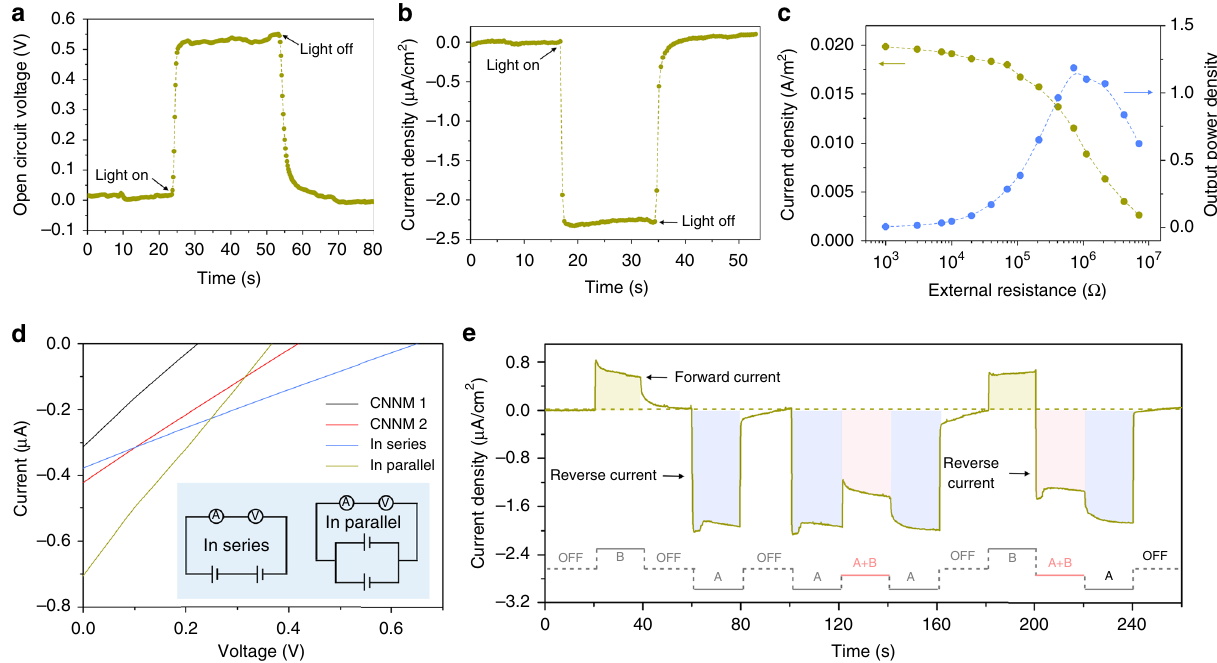
Fig. 4 Photoelectric energy conversion system based on ion pumping in symmetric electrolyte. The electrolyte is 0.001 M KCl. a , b Open circuit voltage ( a ) and current density ( b ) generated by light-induced ions transport. c The generated power can be output to external circuit and supply an electronic load. The output power density reaches its peak value of 1.2 mW/m 2 at resistance of ∼ 400 k Ω . d Current – voltage curves of two individual CNNM and their series and parallel connections. Inset: circuit diagram. CNNM 1: 46 mW/cm 2 ; CNNM 2: 143 mW/cm 2 . e Light with different power density (A side: 143 mW/cm 2 ; B side: 46 mW/cm 2 ) from different direction resulted in alternating current